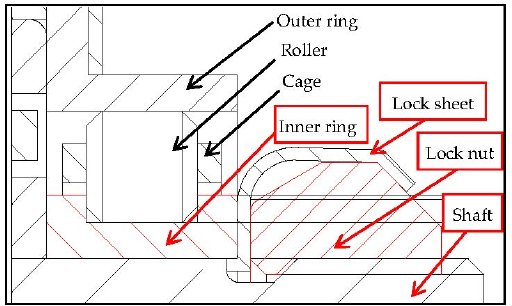
Figure 2. Installation schematic diagram of the cylindrical roller bearing.